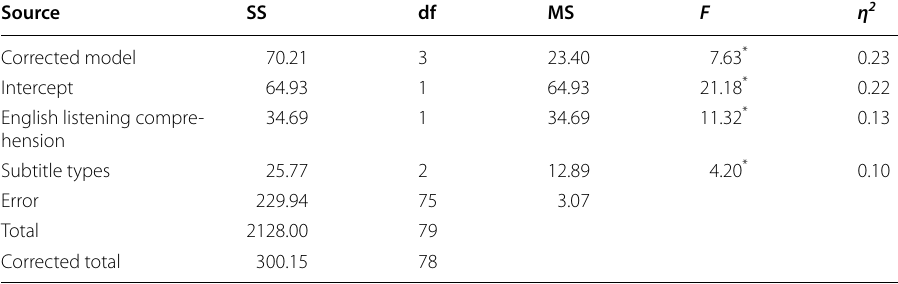
Table 3 The one-way ANCOVA result on overall learning comprehension controlling for English listening comprehension